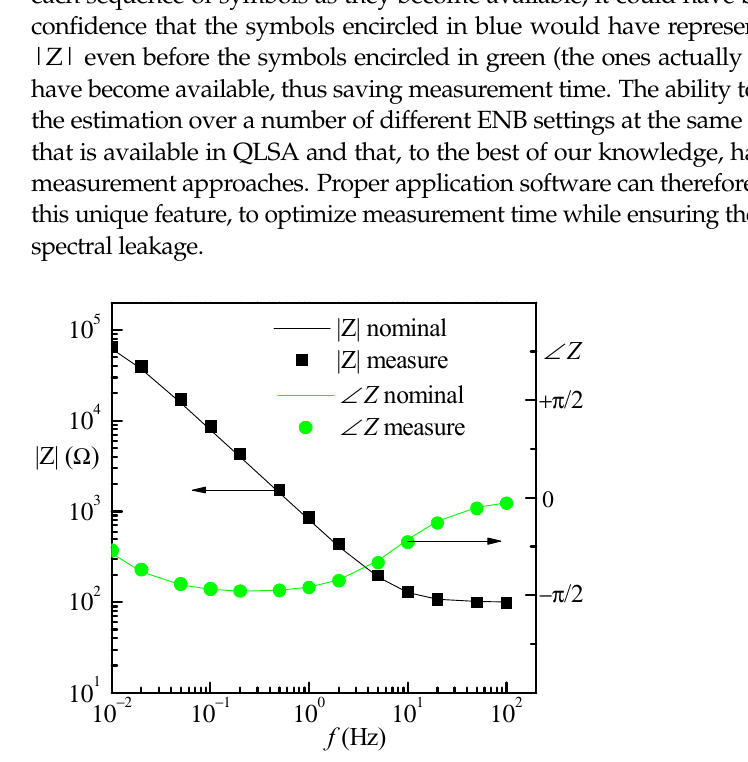
Figure 9. Result of test measurements on the impedance in Figure 6b. DC bias across the DUT was set to 500 mV and the AC amplitude of the test voltage was 10 mV at all frequencies. Quite good agreement is obtained between measurements (symbols) and the expected values (solid lines).